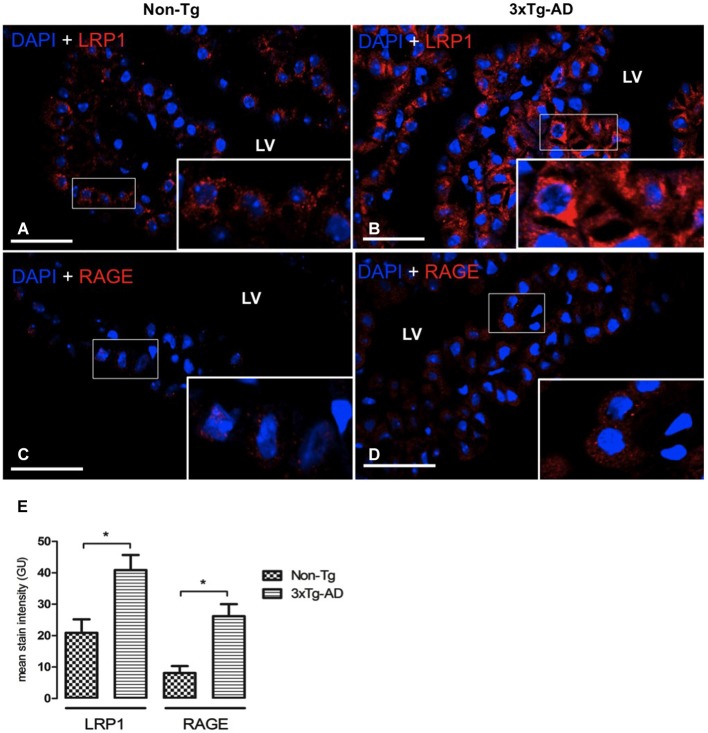
CP confocal microscopy images immunolabeled from Non-Tg (A,C) and 3xTg-AD mice (B,D) stained with anti-LRP1 (A,B) and anti-RAGE (C,D). An increase in cytoplasmic expression of LRP1 and RAGE in epithelial cells of lateral ventricle (LV) of 3xTg-AD compared to Non-Tg mice is shown. On the left bottom (E) are represented values of stain intensitites for LRP1 and RAGE as the means ± SEM; n = eight animals per group; * p < 0.01 3xTg-AD vs. Non-Tg mice. Scale bars, 30 μm.